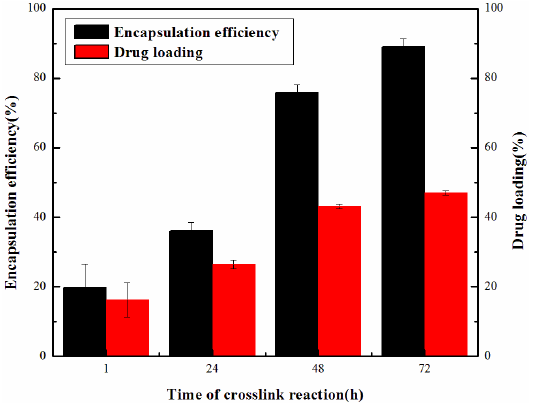
Figure 3. Drug loading and encapsulation efficiency of ABMs prepared with different reaction time by genipin